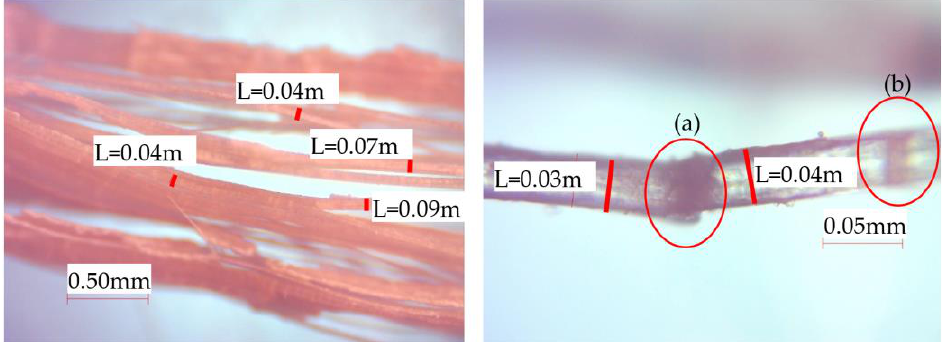
Figure 3. Bundle of nettle fibers under the light microscope. Detail of a growth defect (a) and a dislocation